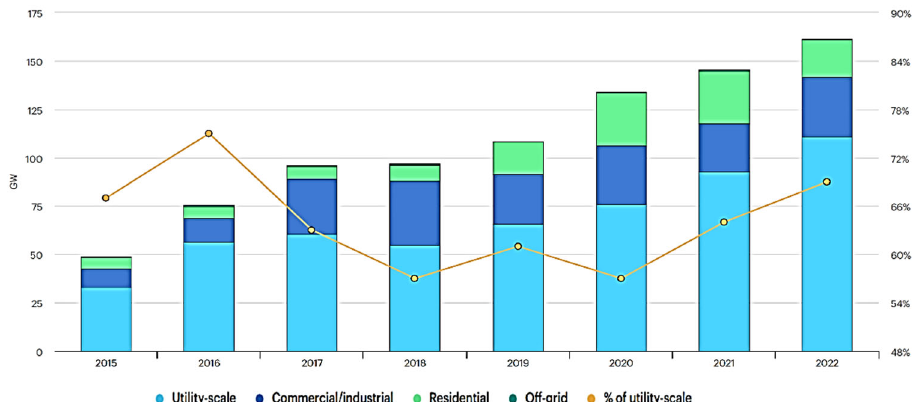
Figure 1. Annual solar PV capacity additions by application segment, 2015–2022 Source: IEA, Annual solar PV capacity additions by application segment, 2015–2022, IEA, Paris https://www.iea.org/data-and-statistics/charts/annual-solar-pv-capacity-additions-by-application-segment-2015-2022, (accessed on 1 October 2022). IEA. License: CC BY 4.0 [2].